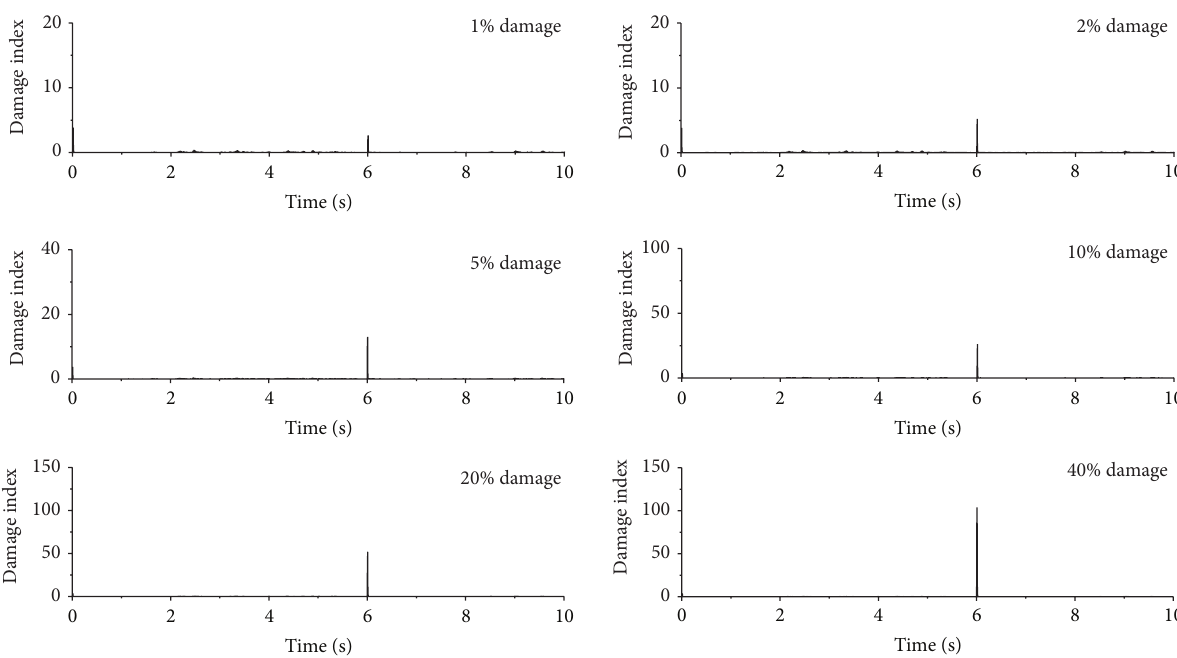
Figure 12: Damage detection using different db wavelets under seismic